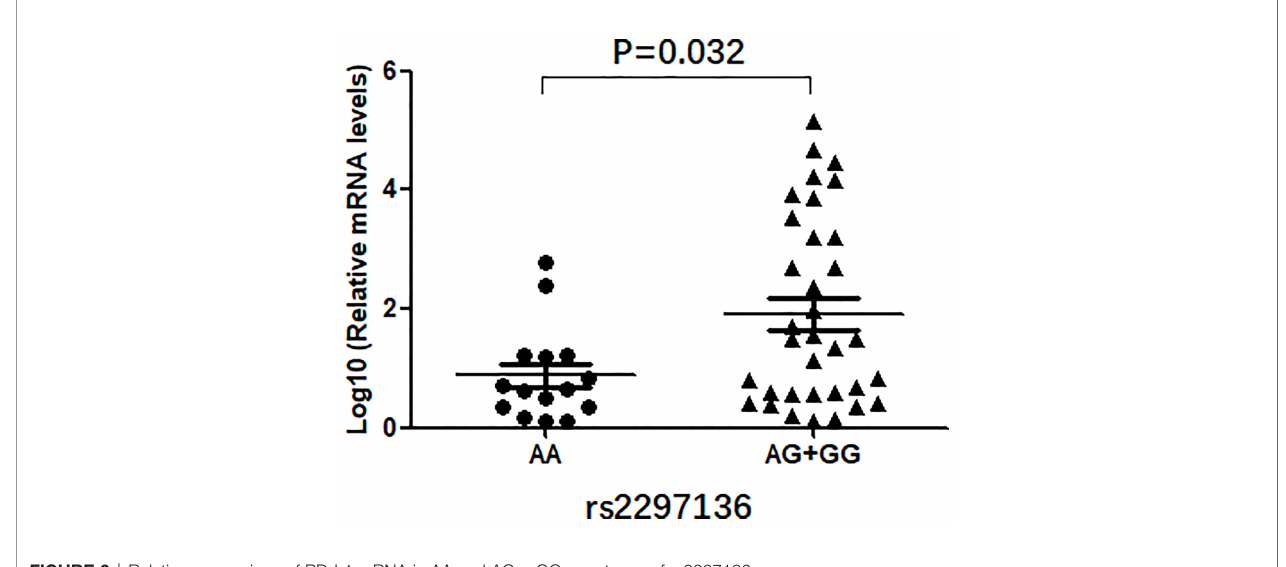
FIGURE 3 | Relative expressions of PD-L1 mRNA in AA and AG + GG genotypes of rs2297136.